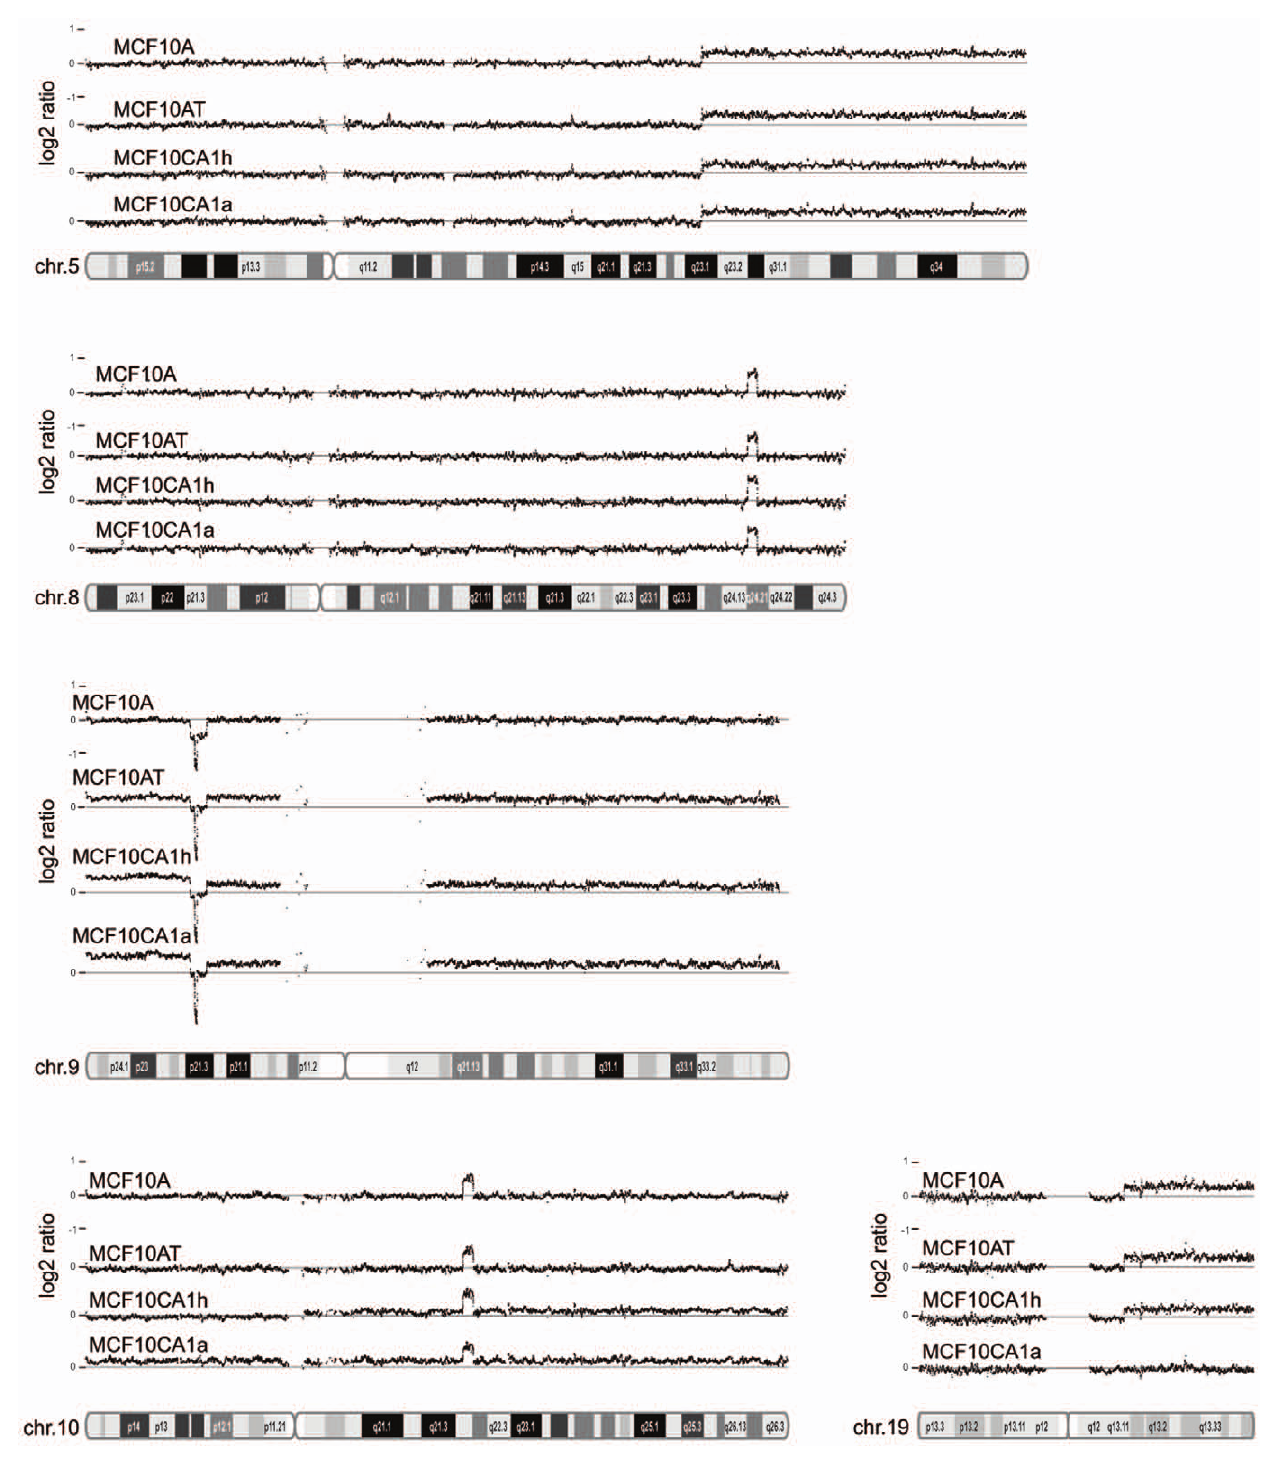
Figure 1. Figure 1 shows DNA copy number variation in chromosomes 5, 8, 9, 10, and 19. The graph was generated using the Affymetrix Genome Browser. Genomic position is displayed on the x-axis and log2ratio (tumor hybridization intensity normalized by diploid HapMap reference samples) is on the y-axis. DNA copy number gains at 5q23.1-qter, 8q24.21, and 10q22.1 are seen in all four cell lines. Homozygous deletion at the CDKN2A locus in chromosome 9p21.3 occurs in all four cell lines. Note that the homozygous deletion (400 kb) is embedded within a hemizygous deletion region (4 Mb). 19q13-qter copy number gain is observed in the MCF10A, MCF10AT, and MCF10CA1h cell lines.